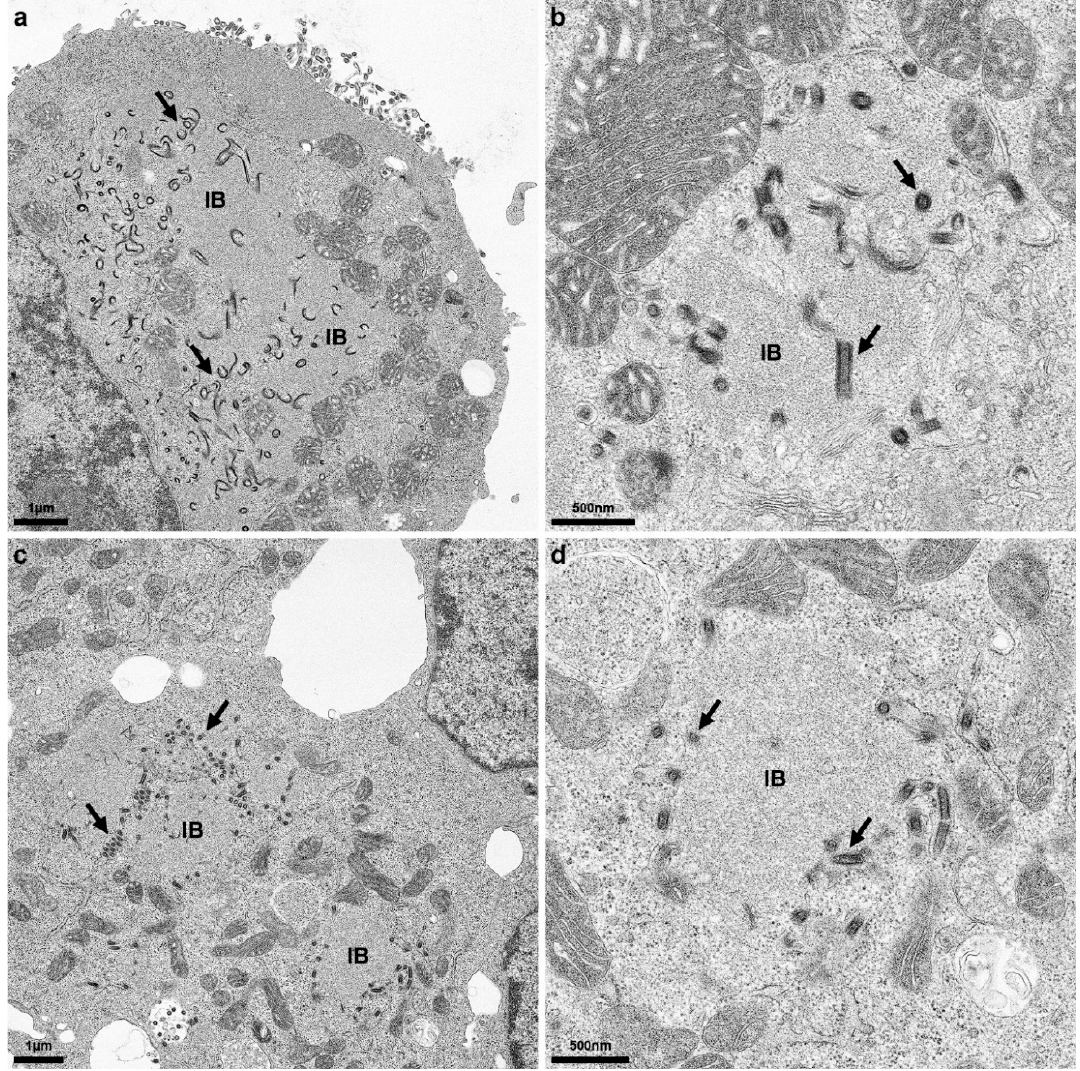
Figure 7. Accumulation of intracellular virus particles at inclusion bodies in rRABV Dog-infected BHK cells. Na 42/13 ( a , b ) and BHK cells ( c , d ) were infected at an MOI of 0.01. Three dpi, cells were fixed and analyzed by transmission electron microscopy. Note: Electron microscopy analysis was performed with rRABV Dog already comprising the D247N mutation. Arrows: accumulation of intracellular virus particle at the surface of cytoplasmic inclusion bodies.